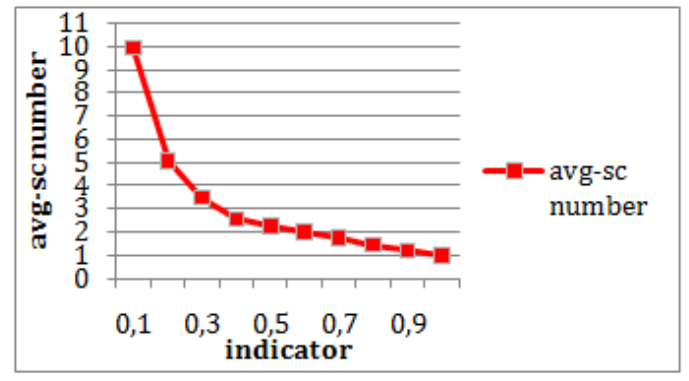
Figure 4. Influence of the factor of supply changeability on the supply chains number in the reverse network